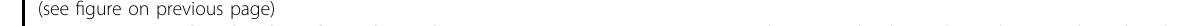
Fig. 1 Nicotine induced and accelerated vascular APN resistance in HFD mice. A Circulation APN level was elevated at 4 weeks and peaked at 6 weeks after nicotine treatment on HFD mice. n = 12 animals/group. * P < 0.05 vs. ND group; # P < 0.05 vs. HFD group. Data were analyzed by two- way ANOVA. B , C . Vascular ring assay exhibited that gAPN-induced vasodilatation was signi fi cantly reduced in nicotine-treated HFD groups compared with the HFD group. gAPN-induced vasodilatation was reduced in nicotine-treated 6 weeks group compared with the ND group. Concentration-dependent vasorelaxation in response to acidi fi ed NaNO 2 was normal. n = 12 animals/group. * P < 0.05 vs. ND group; # P < 0.05 vs. HFD group. Data were analyzed by two-way ANOVA. D The expression of AdipoR1 in vessels after nicotine and HFD treated for 6 weeks. n = 12 animals/ group. * P < 0.05 vs. ND group; # P < 0.05 vs. HFD group. Data were analyzed by one-way ANOVA. NIC, nicotine; HFD, high-fat diet; ND, normal diet; gAPN, globular